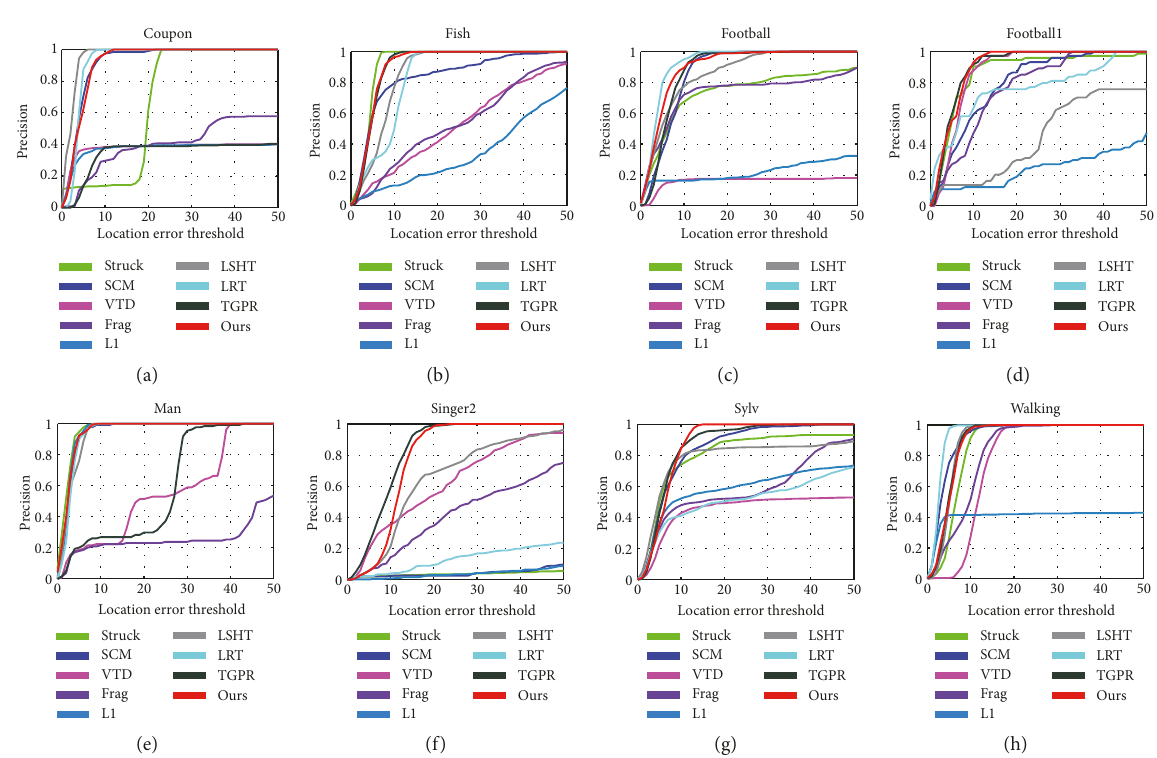
Figure 1: Precision plots in terms of location error threshold (in pixels).